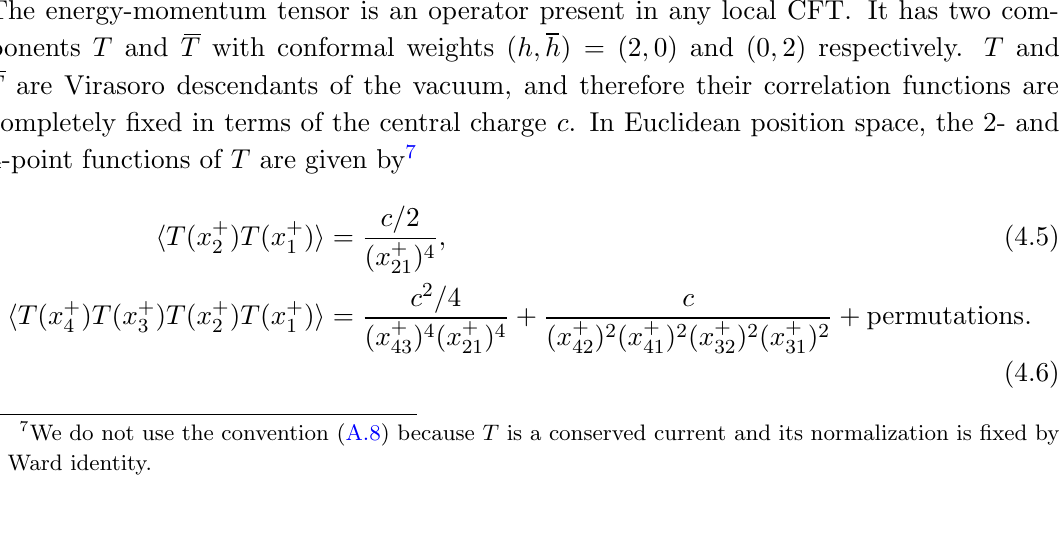
Figure 3 . Contribution to the conformal block expansion of the 4-point function Ising model, for two di(cid:11)erent con(cid:12)gurations of momenta corresponding to those of (cid:12)gure 2. Only the absolute value of the contributions is shown, not their sign. The horizontal axis indicates the scaling dimension of the operators and the color encodes the spin (from violet for spin s = 0 to red for spin s = (cid:1)). In the convergent case (left panel) the contributions decrease exponentially with the scaling dimension, while in the divergent case (right panel) operators of all scaling dimensions give contributions of similar